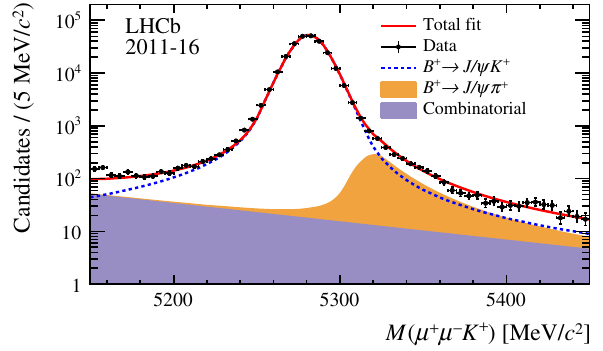
Fig. 2 Fit to the mass distribution of the selected B + → J /ψ K + candidates. The combinatorial background (purple) and misidentified B + → J /ψπ + decays (orange) are stacked up while the B + → J /ψ K + signal is shown as a dashed line. The data points are shown as black points with the total fit overlaid as a red solid line